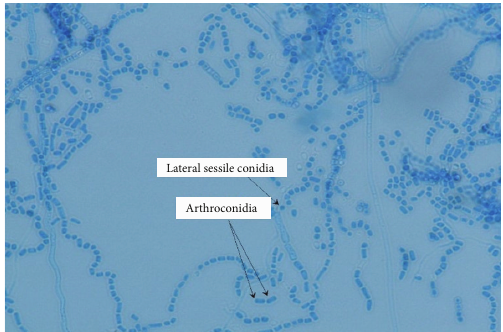
Figure 2: Microscopic examination of corneal scrape material stained with lactophenol cotton blue, demonstrating the presence of arthroconidia and spherical blastoconidia ( × 100